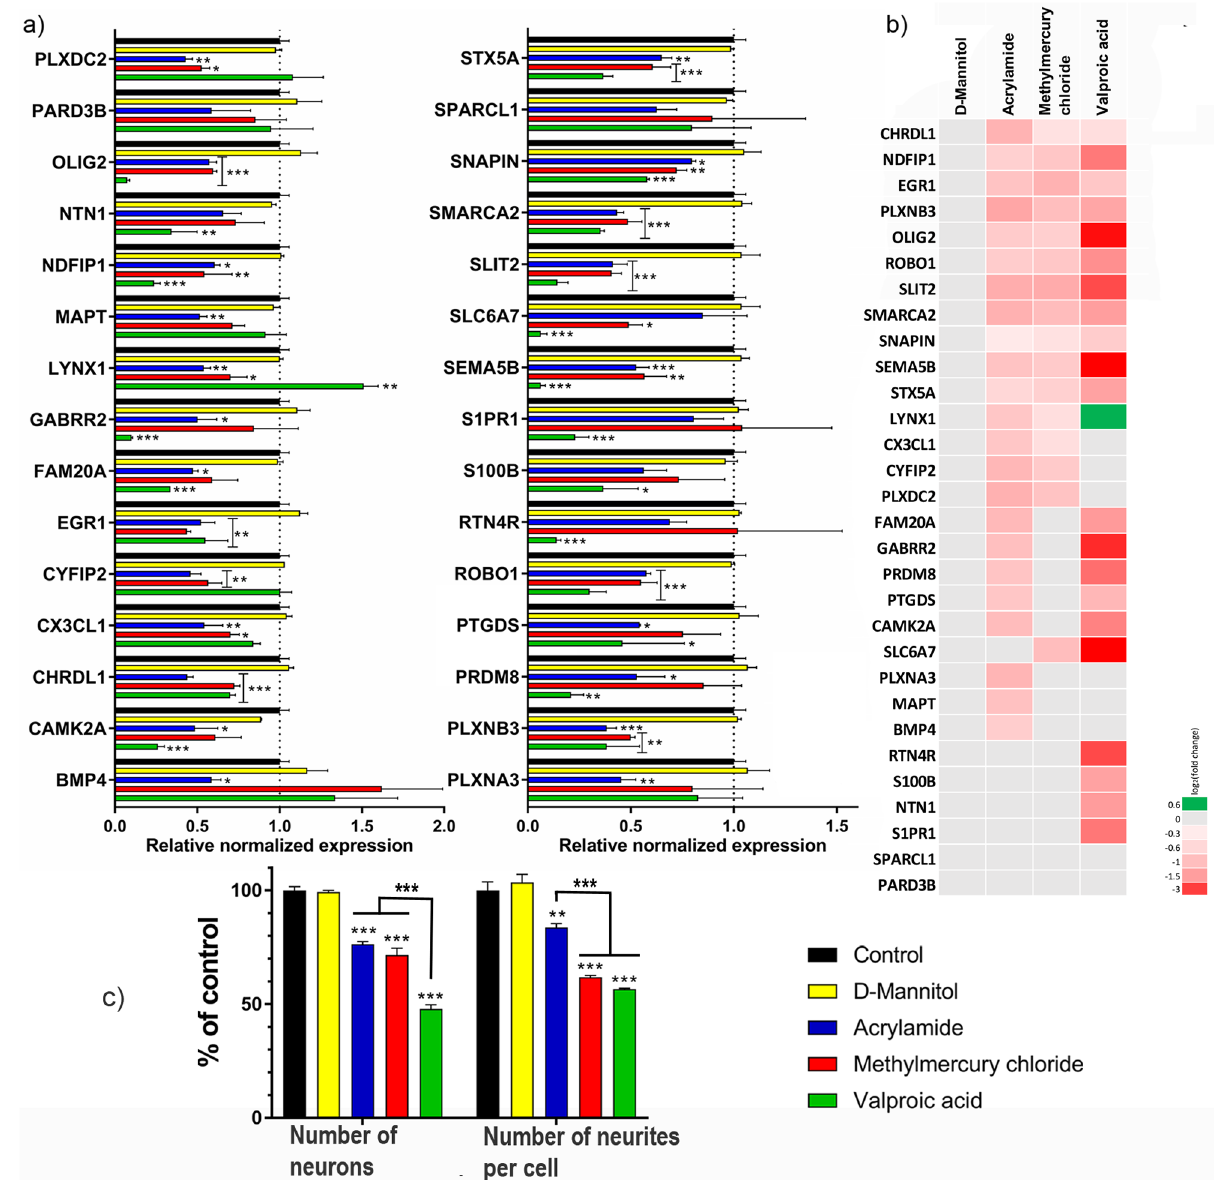
Fig 7. The effect of D-mannitol (negative control), acrylamide(ACR), methylmercury chloride (MeHg) and valproic acid sodium salt (VPA) on gene expression, the number of neurons and neurites per cell in differentiating C17.2 cells. a) RT-qPCR of all 30 genes after 10 days of differentiation and exposureto the IC10 of said compounds(70 μ M of ACR, 90 nM of MeHg and 100 μ M of VPA. D- mannitol did not show any cytotoxicity for the concentrations used, and 1 mM was chosen for cellularexposure) b) Heatmap of the 30 genes expressionduringexposure to the 4 compounds.The log2(foldchange)for the contrasts as comparedto the control (unexposed) are illustratedc) the numberof neuronsand the number of neuritesper cell decreased after exposure to all 3 neurotoxic compounds. The data are presentedas the mean of 3 independent experiments performed in duplicates. Results were analyzedusing two-way ANOVA followed by Dunnett’s multiplecomparisons test. The bars represent the mean ± SEM. * p (cid:20) 0.05, ** p (cid:20) 0.01, *** p (cid:20) 0.001 comparedto control (cells exposedto only cell medium)or betweenthe 3 different compounds(ACR, MeHg and